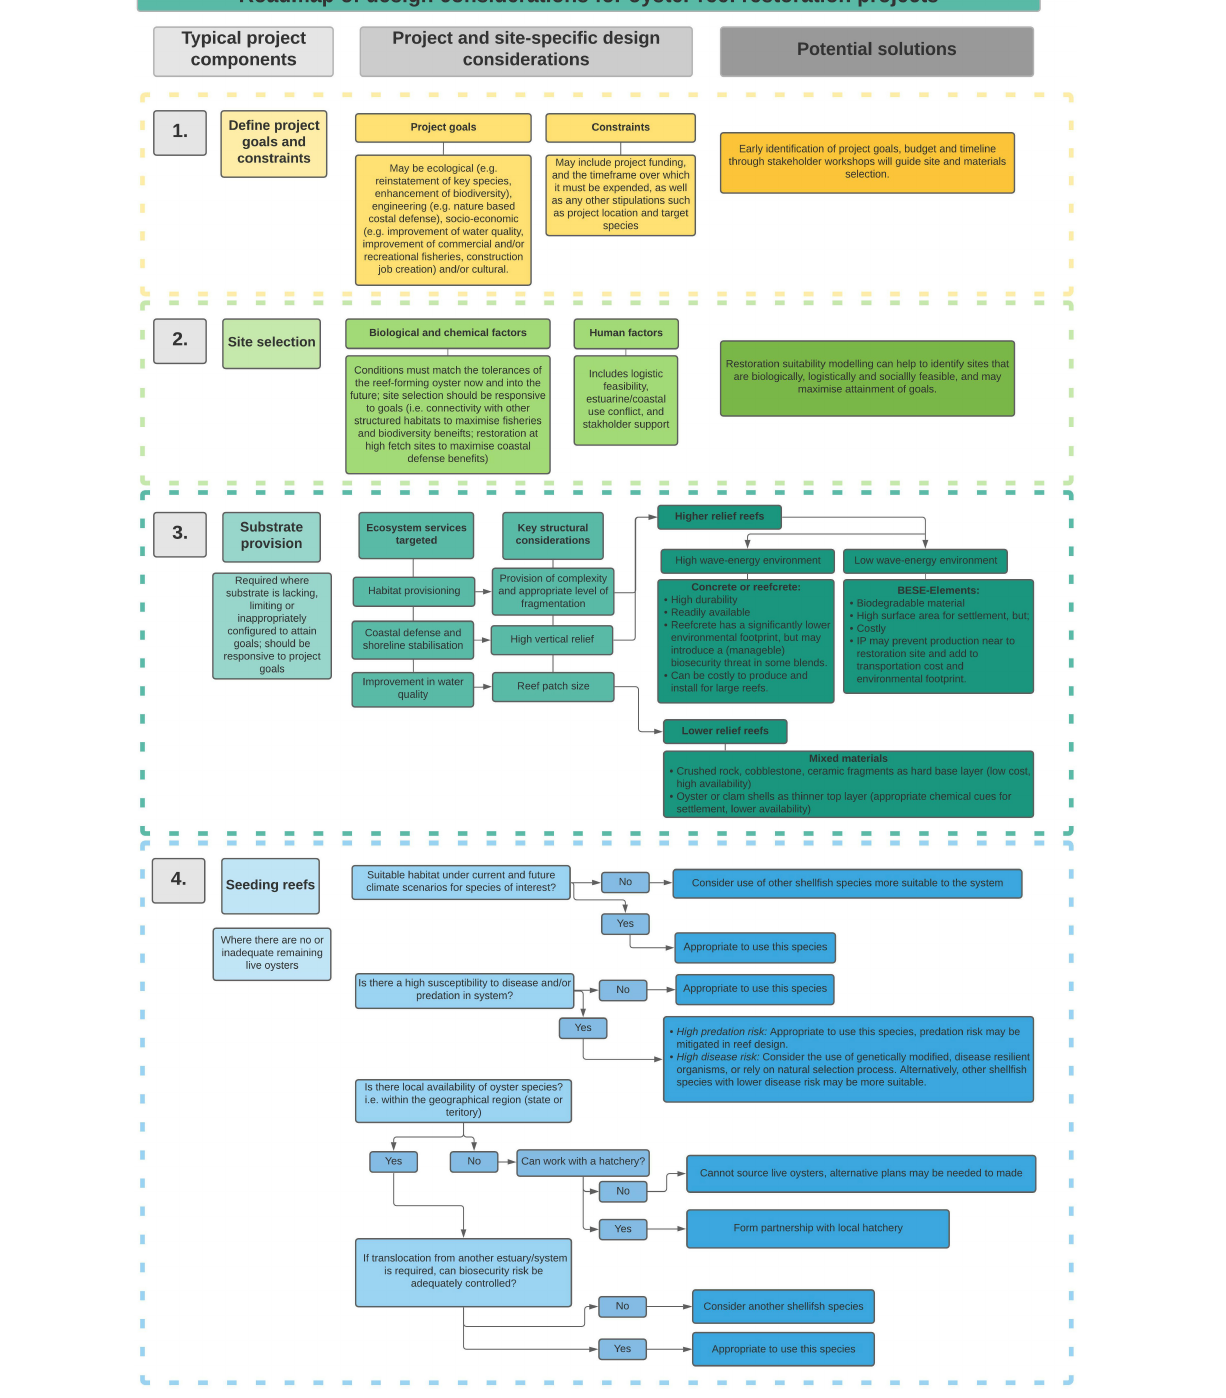
and may vary spatially within these (Waldbusser et al.,